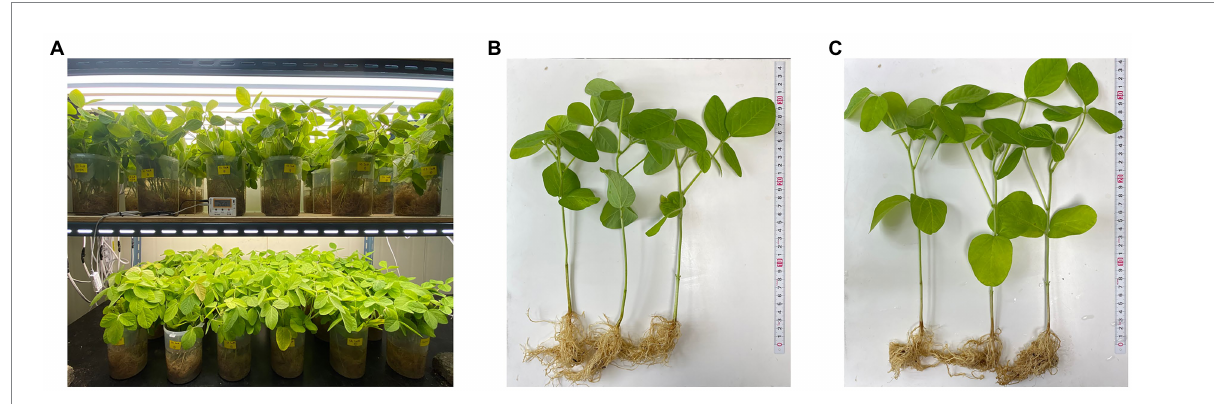
FIGURE 1 (A) Process of salicylic acid (SA) treatment on soybean plants. (B) Control soybean plants. (C) Soybean plants after treatment with 3 mM of SA for 24